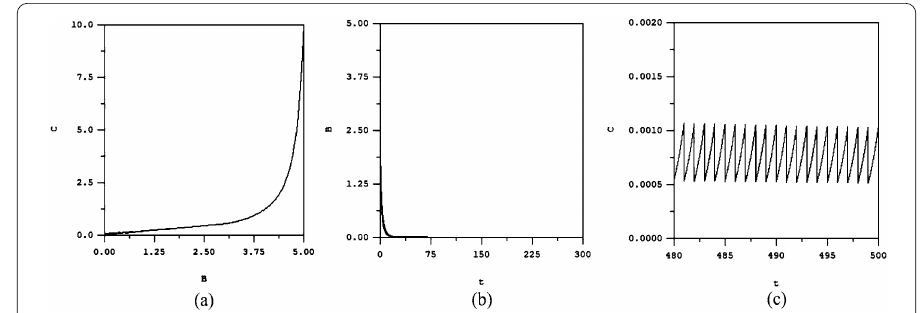
Figure 1 A computer simulation of Eqs. (1a)–(1d). The solution trajectory tends toward the oscillatory solution (0, ˜ C ( t )) as time progresses. Here, a 1 = 0.5, a 2 = 0.8, b 1 = 0.5, r 1 = 0.9, d 1 = 0.01, d 2 = 0.1, h 1 = 2, h 2 = 5, h 3 = 0.3, α = 0.5, β = 0.5, T = 1, B (0) = 5, and C (0) = 10. Here, all conditions in Theorem 1 are satisfied. ( a ) The solution trajectory projected on the ( B , C )-plane. ( b ) The time series of the population density of brown planthoppers ( B ) tending to a vanishing level. ( c ) The time series of the population density of Cyrtorhinuslividipennis ( C ) exhibiting positive oscillation